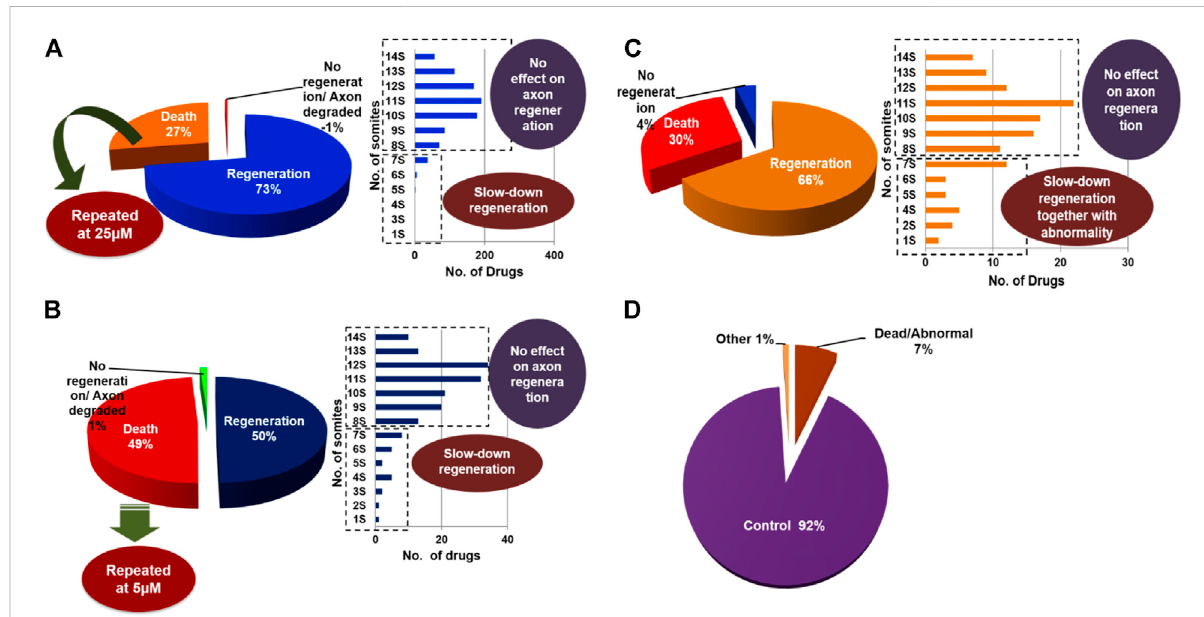
FIGURE 2 At the initial screening concentration most of the compounds were causing death and were repeated further at a lower concentration. Pie charts are showing the regeneration of M-cell in compound-treated larvae at (A) 100 µM, (B) 25 µM, and (C) 5 µM, respectively. Additionally, bar diagramsareshowingregenerationpatternsi.e.,somiteno.ofM-cellrecoveredintreatedlarvae. (D) Thepiechartrepresentstheclassi fi cationofthe whole library ’ s PDS results including all